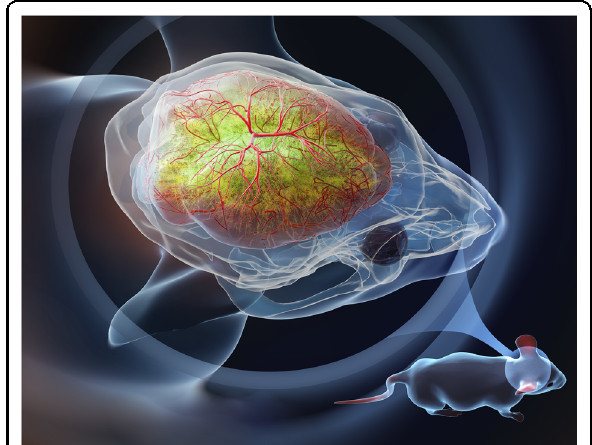
Fig. 1 TIS chronic window for imaging the mouse brain structure and